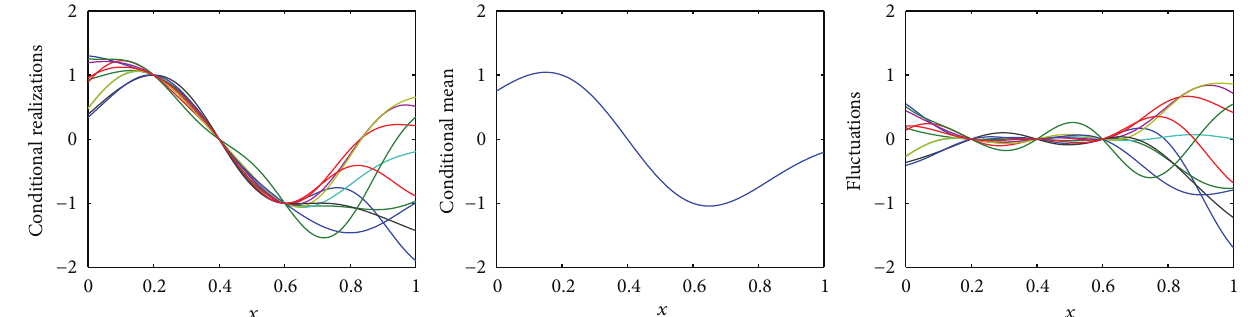
̃ Y (𝑥) Figure 2: Illustration of a conditional representation of a random one-dimensional field on [0,1] with Gaussian covariance function (10) with 𝜂 = 0.3 and 𝜎 = 1 . We use 𝑁 = 100 terms and 𝑁 𝑚 = 3 data points x ∗ = (0.2, 0.6, 0.8) with Y ( x ∗ ) = (1, 0, −1) Left: first 10 realizations ̃ Y (𝑥,𝜔 ) , 𝑘 = 1,...,10 . Middle: the conditional mean 𝑌(𝑥) as in (27). Right: the fluctuations of individual realizations which are added to of 𝑘 𝑌(𝑥) to produce ̃ Y (𝑥) .